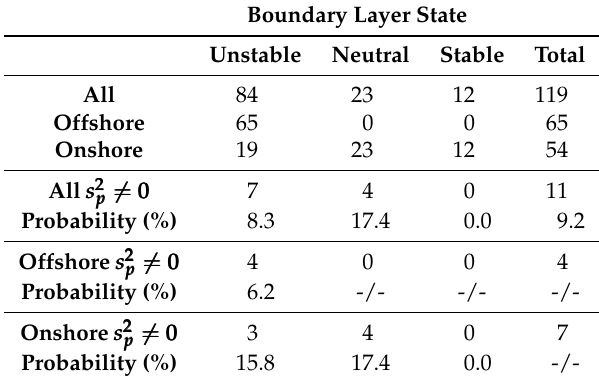
Table 3. Correlation of the occurrence probability of a high shape factor to boundary layer state for all 119